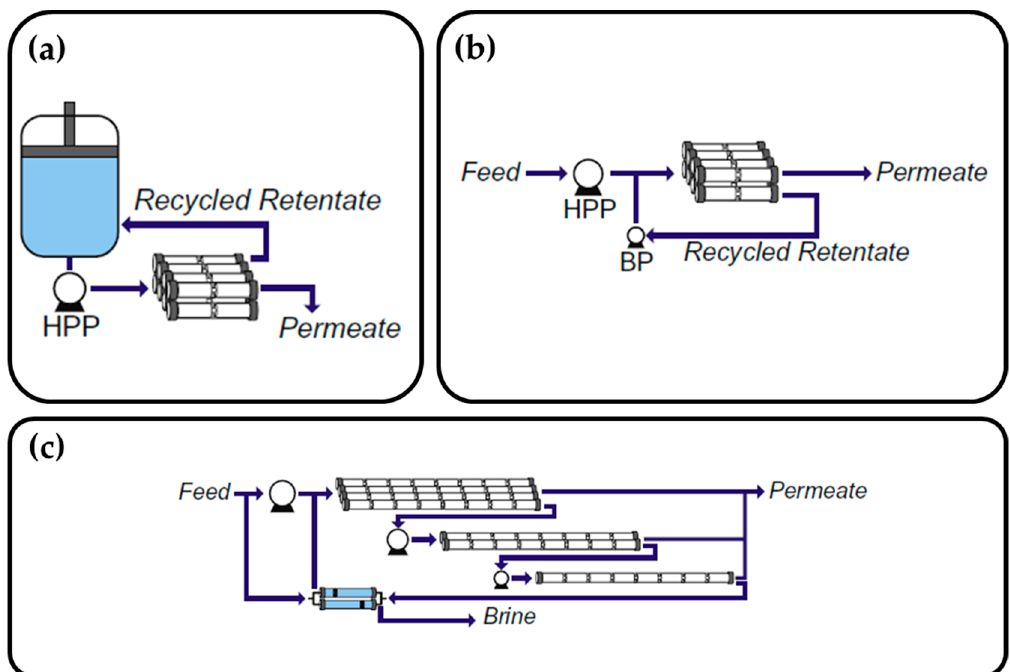
Figure 7. The schematic illustrations of the configurations of each RO type: ( a ) batch-configuration, ( b ) semi-batch configuration, and ( c ) multistage configuration. In these figures, HPP stands for the high-pressure pump and BP stands for the brine pump [61]. The figure is reproduced from Reference [61] with permission.